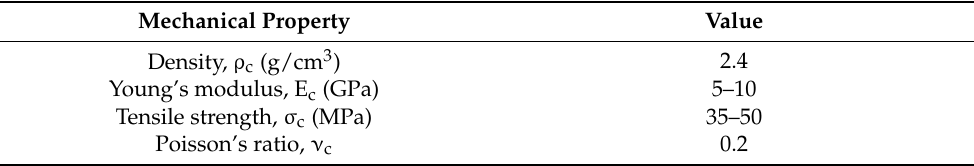
Table 2. Mechanical properties of composite material that specimens were made from.